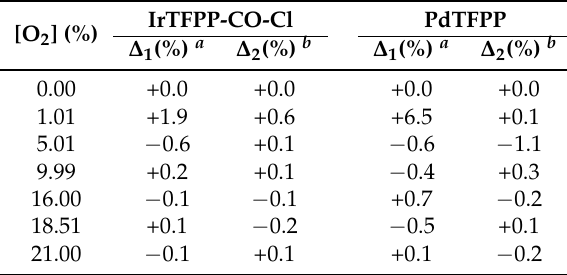
Table 4. Relative deviations between measured lifetimes ratios and calibration curves for PS optodes. IrTFPP-CO-Cl PdTFPP [O 2 ] (%) ∆ a ∆ b ∆ a ∆ b 2 (%) 2 (%) 1 (%) 1 (%) 0.00 +0.0 +0.0 +0.0 +0.0 1.01 +1.9 +0.6 +6.5 +0.1 5.01 − 0.6 +0.1 − 0.6 − 1.1 9.99 +0.2 +0.1 − 0.4 +0.3 16.00 − 0.1 − 0.1 +0.7 − 0.2 18.51 +0.1 − 0.2 − 0.5 +0.1 21.00 − 0.1 +0.1 +0.1 −